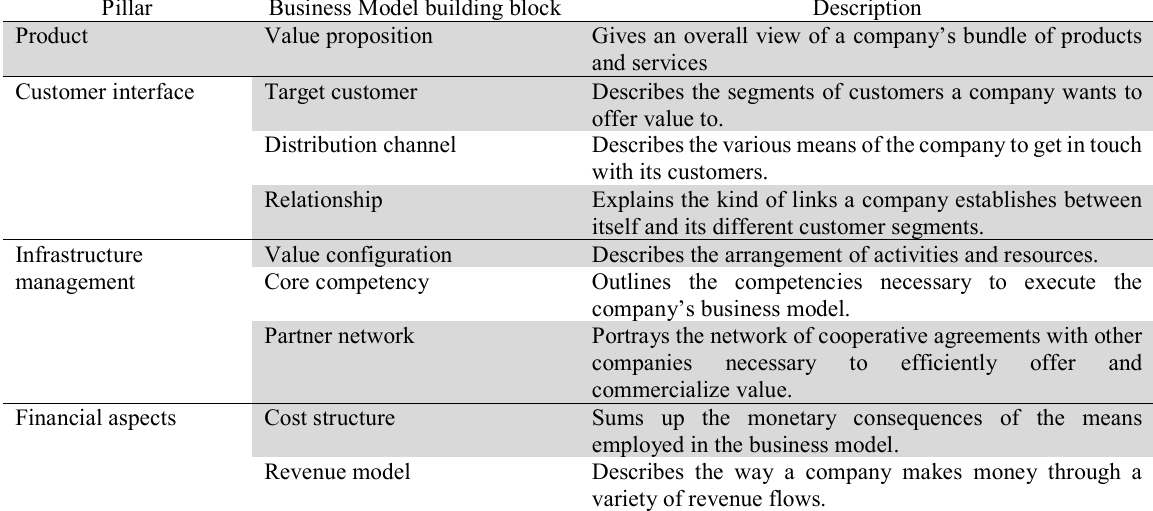
Business Model building